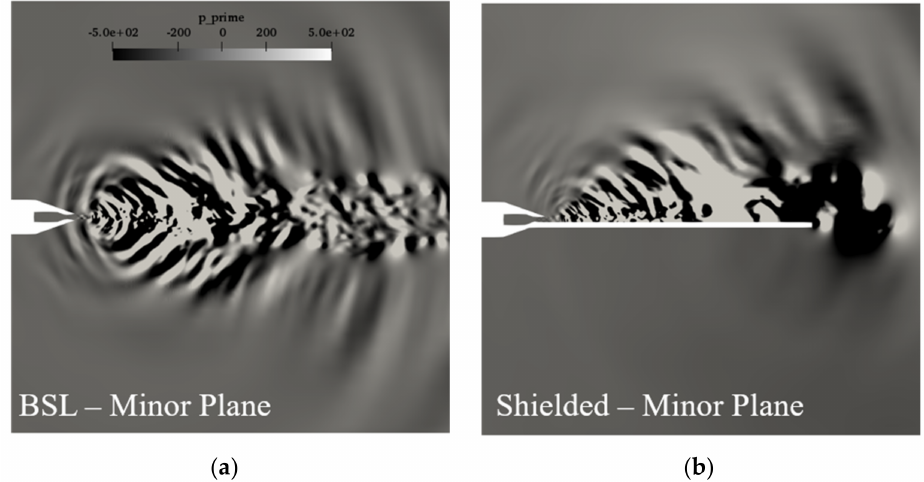
Figure 28. Instantaneous fluctuating pressure, p (cid:48) [ Pa ] . ( a ) Baseline (BSL) case, ( b ) Shielded